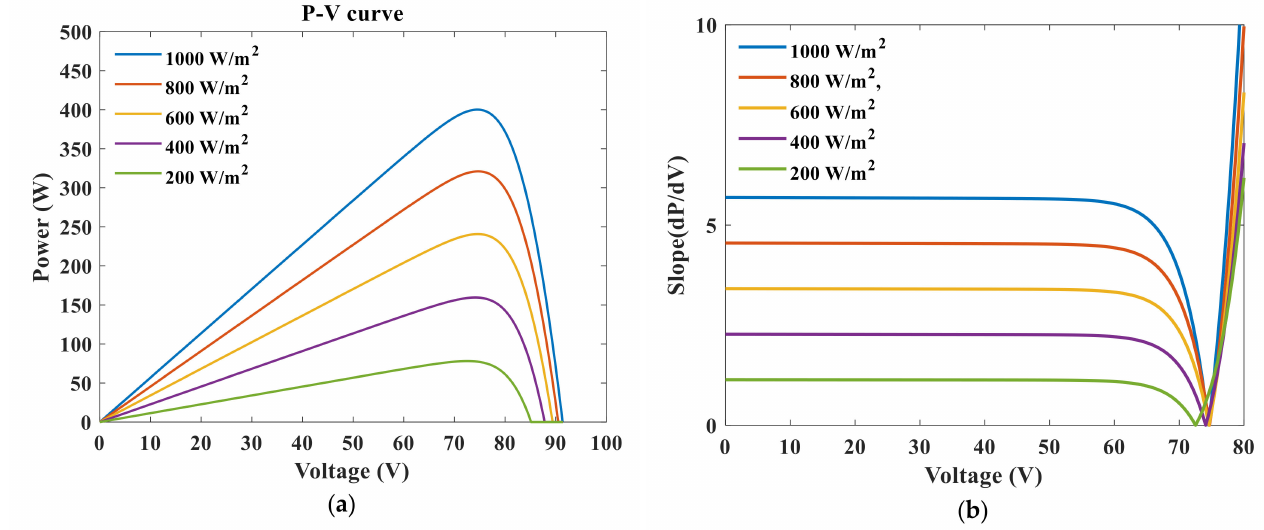
Figure 2. Characteristic curves of the utilized JAM5(L)72-200/SI solar cell ( a ) P–V curves ( b ) absolute slope of P–V